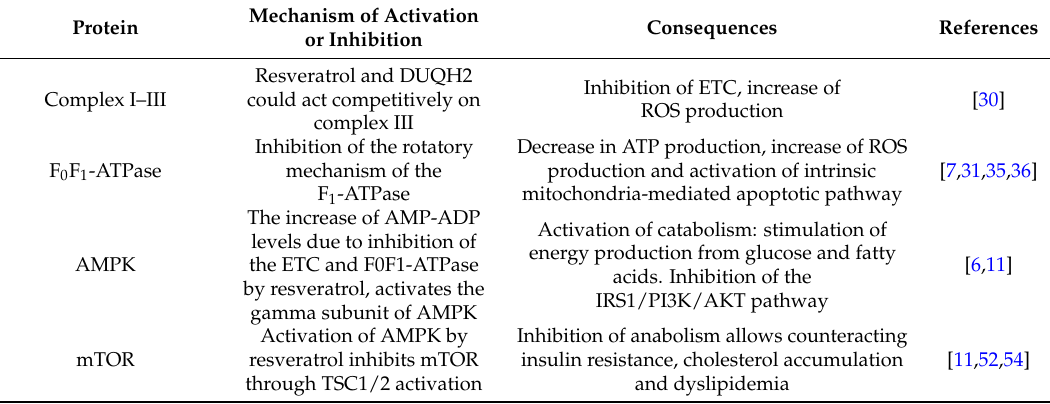
Table 1. Resveratrol targets sorted according to the mechanism proposed in this